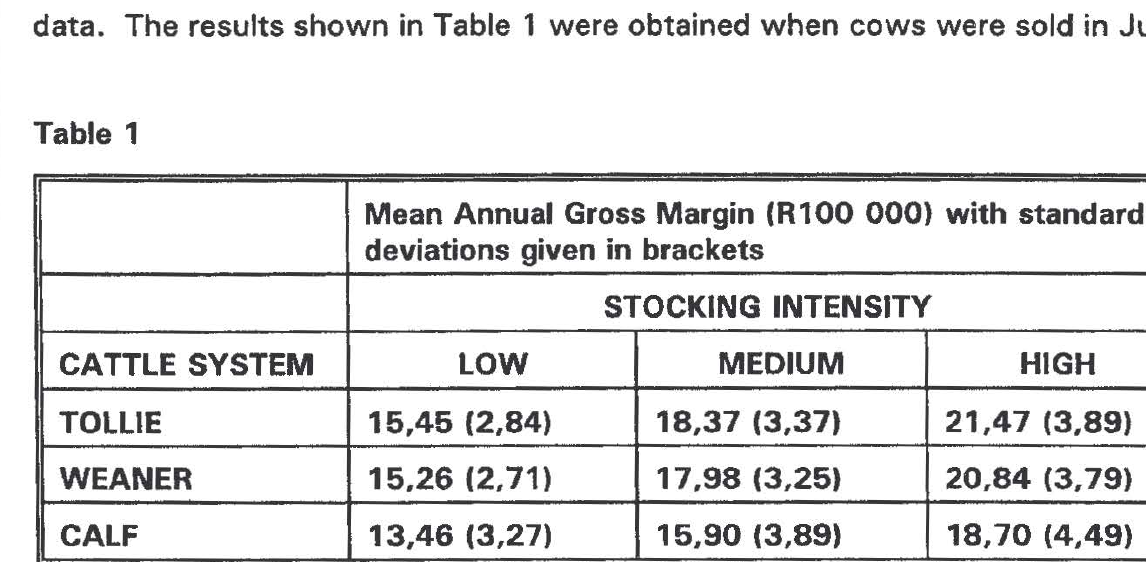
Mean Annual Gross Margin (R 100 000) with standard deviations given in brackets STOCKING INTENSITY CATTLE